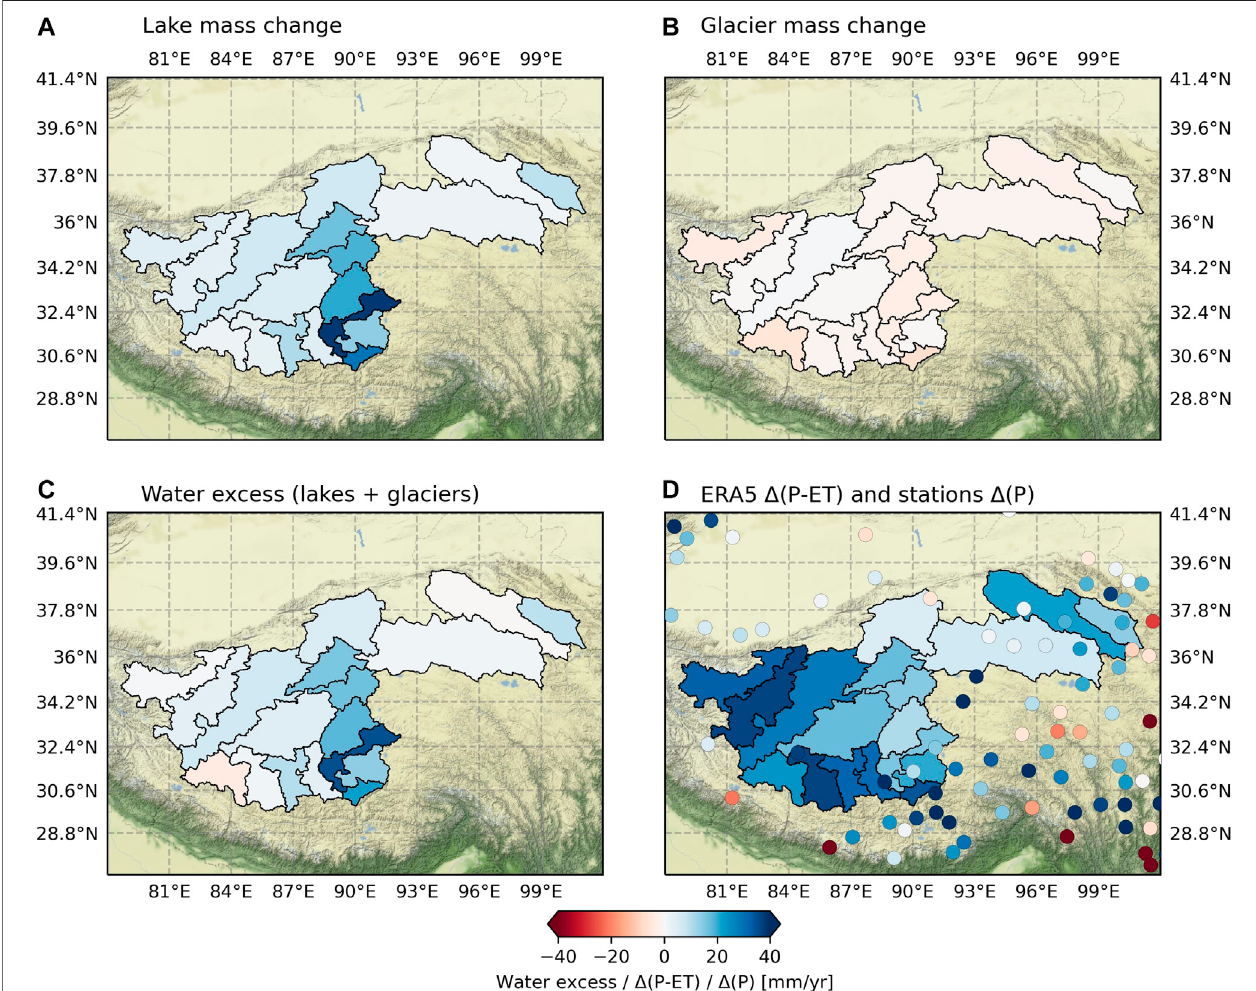
FIGURE4| Lake (A) , glacier (B) and lake+ glacier (C) rateofmasschangedistributedover the basin area(in mm/yr). Δ (P-ET) fromERA5 reanalysis, and Δ (P)from the meteorological stations (dots) for the period 1994 – 2015 relative to 1979 – 1993 (D) .